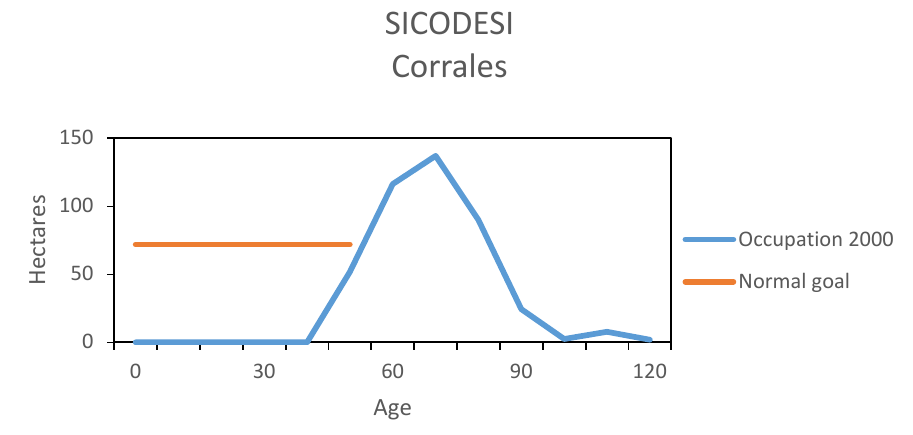
Figure 3. Goal and final (2000) age distribution in Corrales, managed under SICODESI.